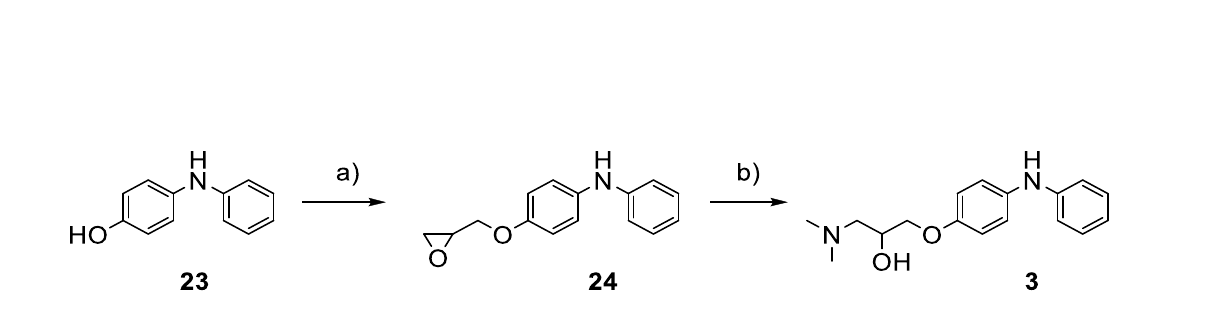
Figure 5. Reagents, solvents, and conditions: ( a ) (±)-epichlorohydrin, MeCN, K 2 CO 3 , 80 °C, 16 h; ( b ) Me 2 NH × HCl, MeOH, 70 °C, 24 h.